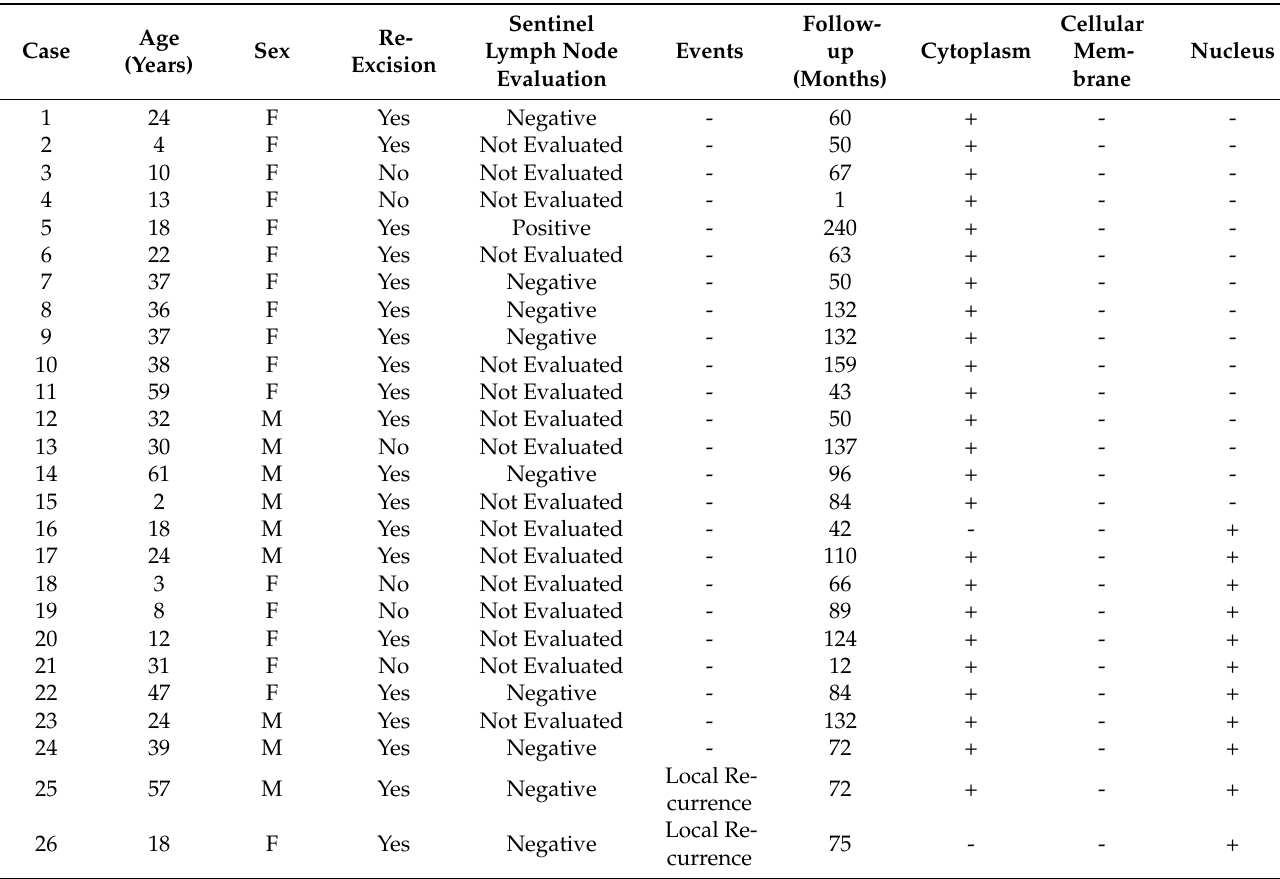
Figure 3. Photomicrographs of an atypical Spitz tumor harboring an NTRK3 fusion. ( A ): The lesion was an exophytic nodule with epidermal collarette, flat lower border, and widespread epidermal hyperplasia with long and thin filigree-like rete ridges enveloping superficial nests. (H&E staining, magnification 40×, scale bar 200 µm). Inset: melanocytes were predominantly elon- gated, with ground-glass cytoplasm, and arranged in fascicles (H&E staining, magnification 200×, scale bar 40 µm). ( B ): In some areas, the melanocytes lacked immunoreaction (pan-TRK immunostaining, magnification 40×, scale bar: 200 µm). Inset: mela- nocytes without immunoreaction (pan-TRK immunostaining, magnification 200×, scale bar 40 µm); ( C ): Most of the melanocytes showed strong nuclear immunoreaction (pan-TRK immunostaining, magnification 40×, scale bar: 200 µm). Inset: melanocytes with nuclear immunoreaction (pan-TRK immunostaining, original magnification 200×, scale bar: 40 µm). ( D ): Break-apart FISH analysis confirmed NTRK3 rearrangement showing the typical pattern: one fusion signal (yellow arrows) and split signals 3 ′ (red arrows) and 5 ′ (green arrows) (ZytoLight SPEC NTRK3 Dual Color Break Apart Probe, original magnification 1000×, scale bar 5 µm).